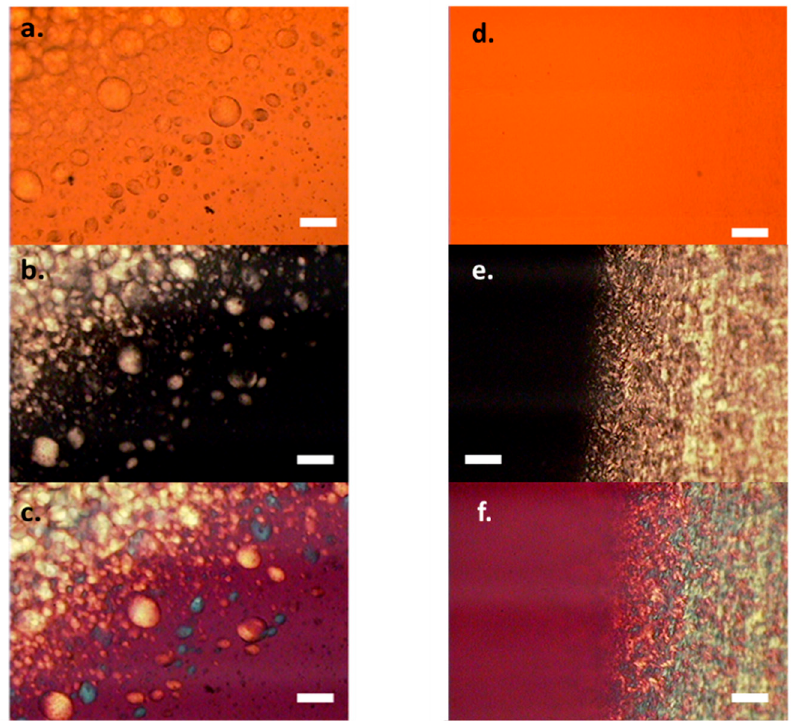
Figure 4. Optical microscope images of 8%wt. CNC with 0.16%wt. MWNT dispersion ( a – c ) and 8%wt. CNC with 0.16%wt. SWNT dispersion ( d – f ). The images include normal light ( a , d ), polarized